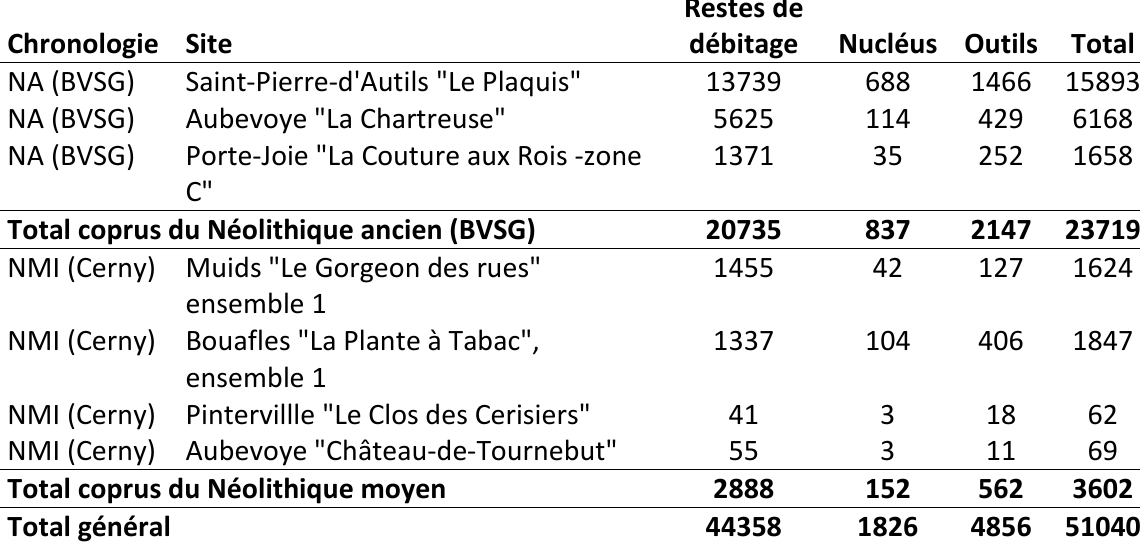
Tableau 1. Décompte général du corpus par sites. Table 1. General count of the corpus by